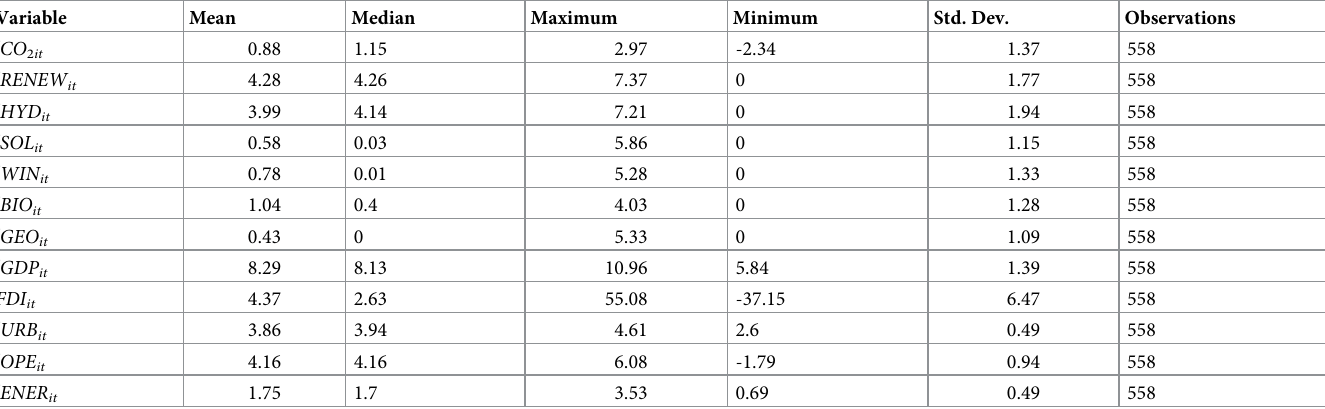
Table 2. Summary statistics of the variables over the years 2000–2018.